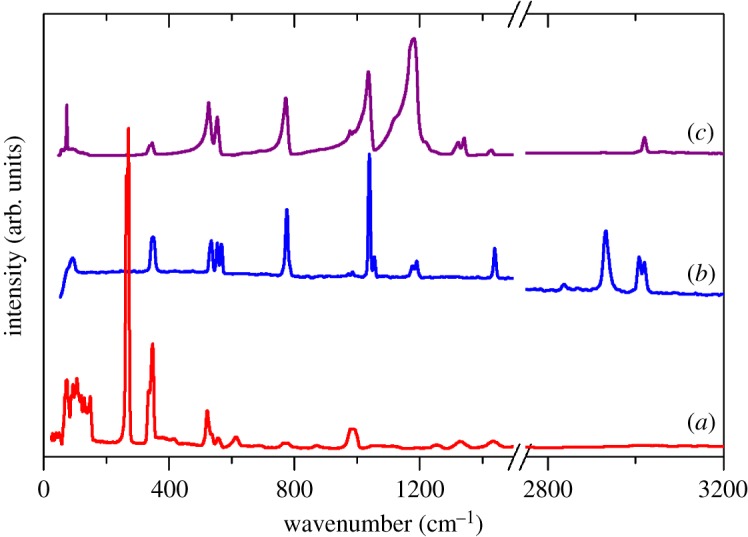
(a) INS, (b) FT-Raman and (c) infrared spectra of Cs(CH3SO3).